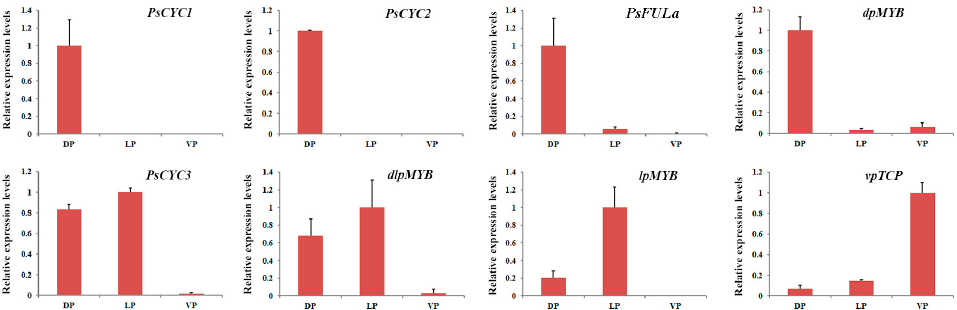
Figure 6. qPCR validation of selected genes with a DV asymmetrical expression patterns in three types of pea petals. PsCYC1 (Unigene0018426), PsCYC2 (Unigene0018425), PsFULa (Unigene0011778), dpMYB (Unigene0031178), PsCYC3 (Unigene0048351), dlpMYB (Unigene0005297), lpMYB (Unigene0082746), and vpTCP (Unigene0087108). Error bars indicate ±